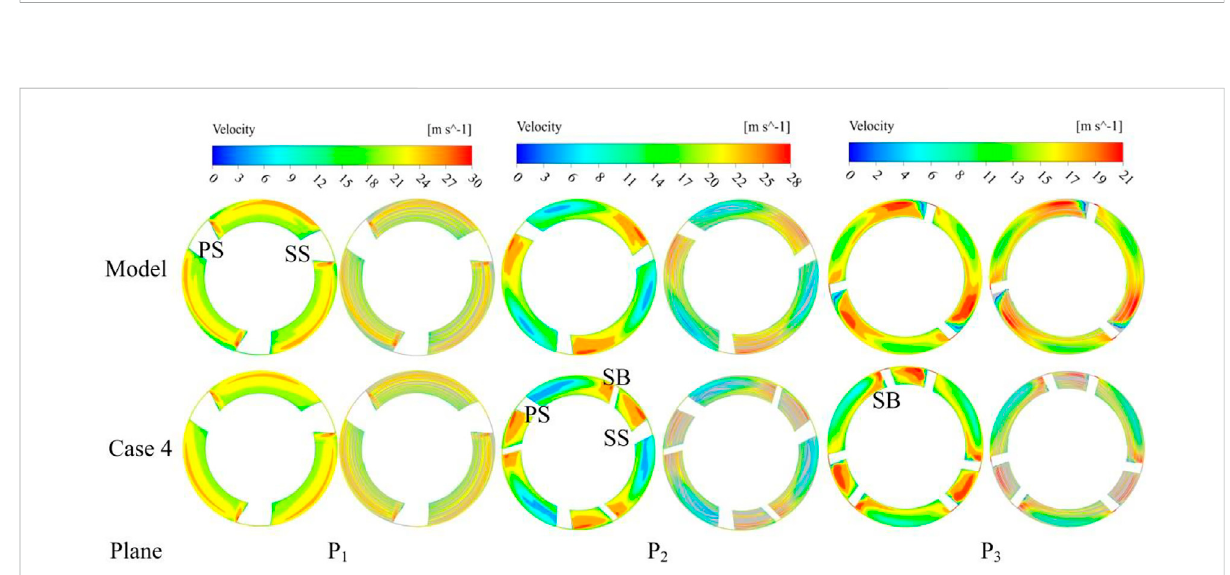
FIGURE 7 Liquid velocity distribution on the section before and after complex